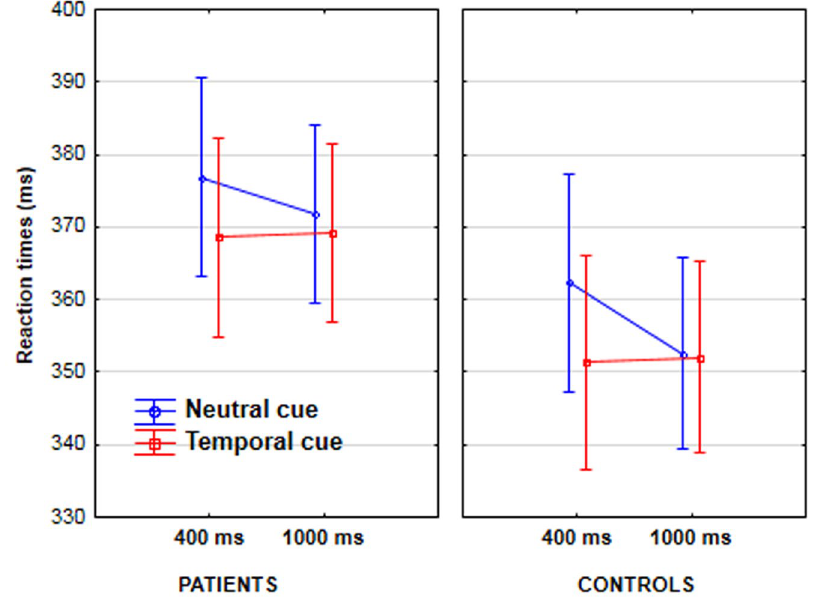
Figure 2. Reaction times in patients (lefthand graph) and controls (righthand graph) as a function of the presence or absence of temporal cues (neutral cues in blue, vs. temporal cues in red), and the foreperiod between the cue and the target (400 vs. 1000